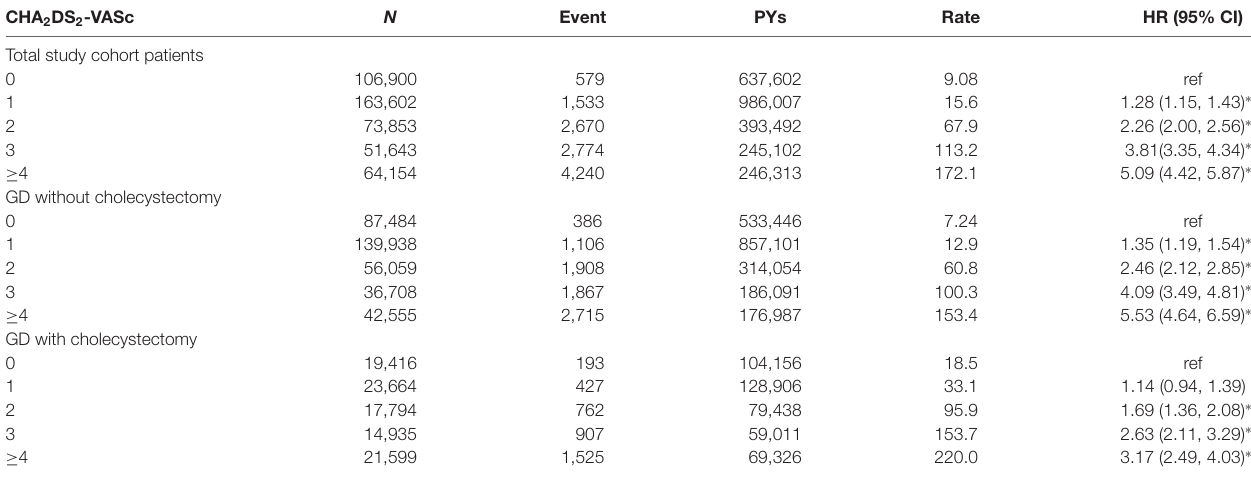
TABLE 3 | Incidence and HRs of AF in study cohort patients stratified by CHA 2 DS 2 -VASc score. CHA 2 DS 2 -VASc N Event PYs Rate HR (95% CI)